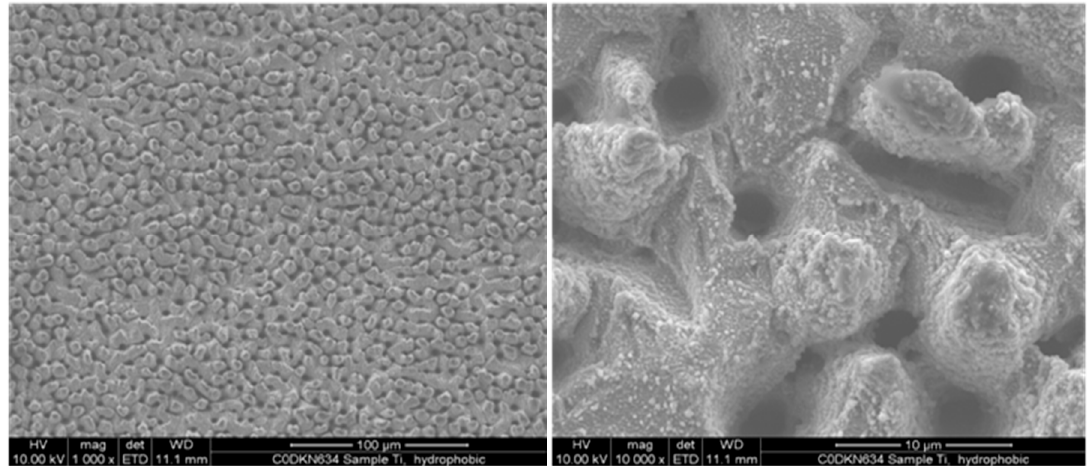
Figure 3. The fabrication of homogeneous hierarchical structures on a metal surface that resulted in hydrophobic traits, presented with different resolutions of 100 µm (left) and 10 µm (right) scale bars.